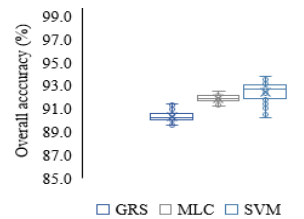
Figure 1. Overall